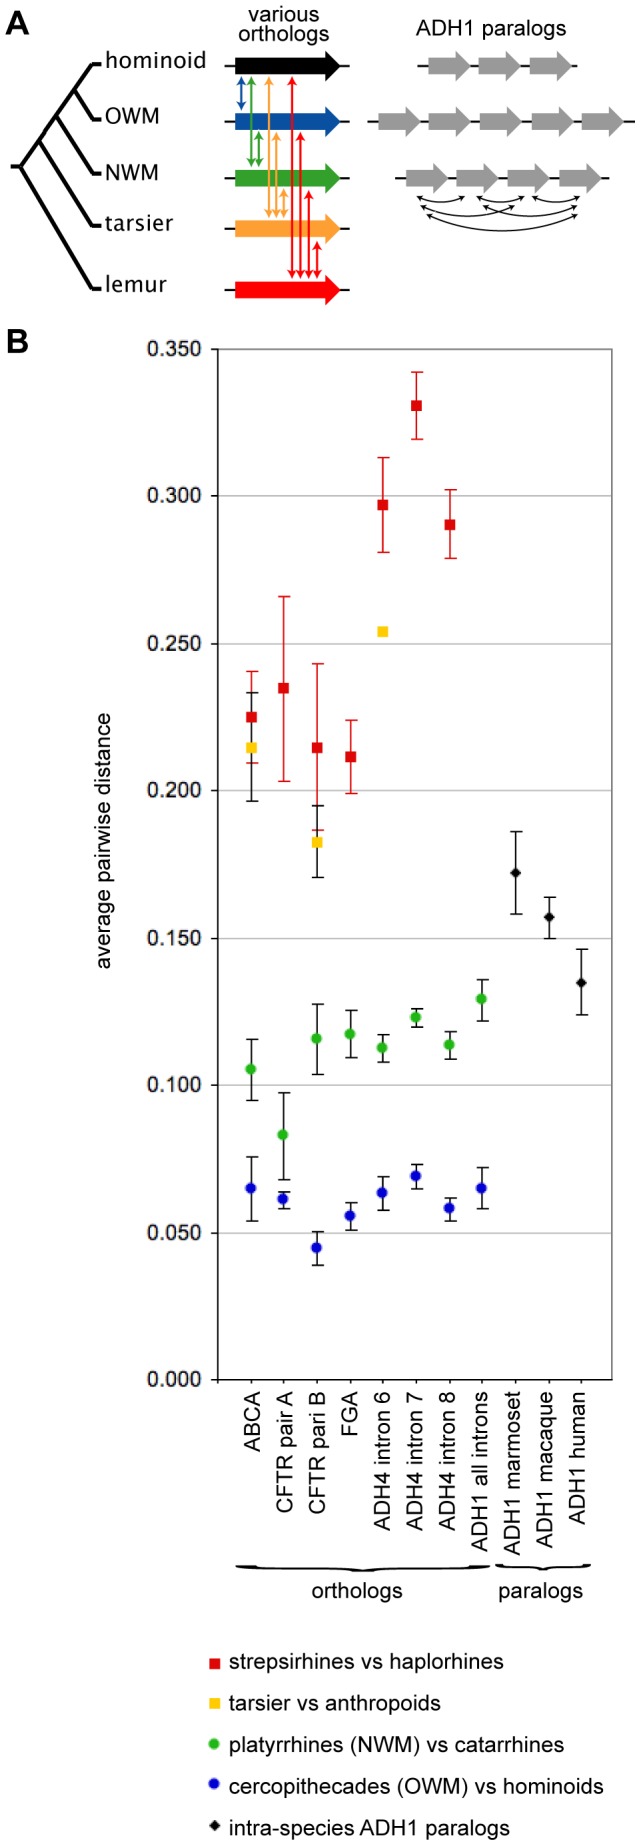
Estimate of the ADH1 paralog duplications relative to the time of the major primate speciation events.The average pairwise distances separating the introns of the ADH1 paralogs were compared with the average pairwise distances separating a set of introns in paired taxa. (A) This schematic illustrates the various ortholog comparisons used to estimate the relative age among the ADH1 paralogs. (B) This plot summaries the data in Table 2 and 3. The distances among the ADH1 paralogs in marmoset, macaque and human (black diamonds) are somewhat larger than those separating catarrhine and platyrrhine orthologs (green circles), implying that these ADH1 paralogs diverged (duplicated) before the catarrhine-platyrrhine split. Conversely, distances separating the ADH1 paralogs in marmoset, macaque and human are somewhat smaller than those separating orthologous introns among strepsirhine and haplorhine (red squares), implying that these ADH1 paralogs diverged after the split between strepsirhine and haplorhine.